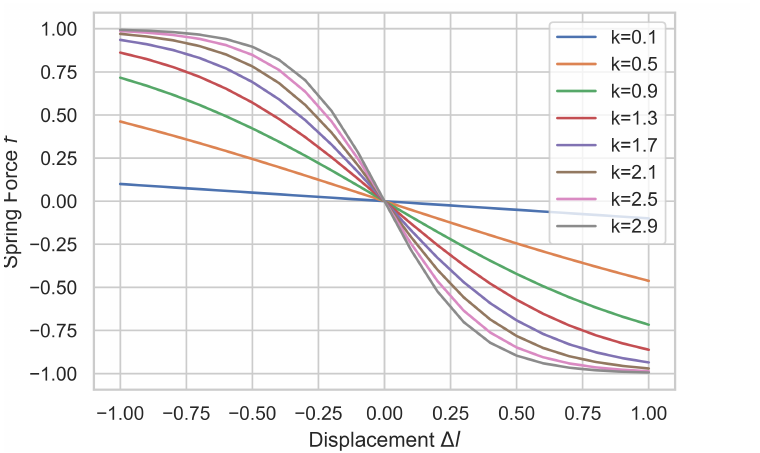
Figure 3. The force displacement curve of the springs used in the simulation at different spring constants k